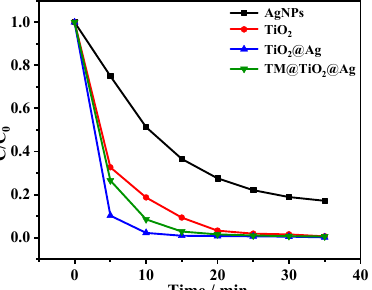
Figure 4. UV-Vis absorption spectra of TM@TiO 2 @Ag with temperature change ( a ); the relationship between LSPR peak wavelength of TM@TiO 2 @Ag and temperature ( b ); the relationship between LSPR peak position of TM@TiO 2 @Ag and temperature cycle ( c ); SERS spectra of 10 − 7 M OFL at dif- ferent temperatures ( d ).